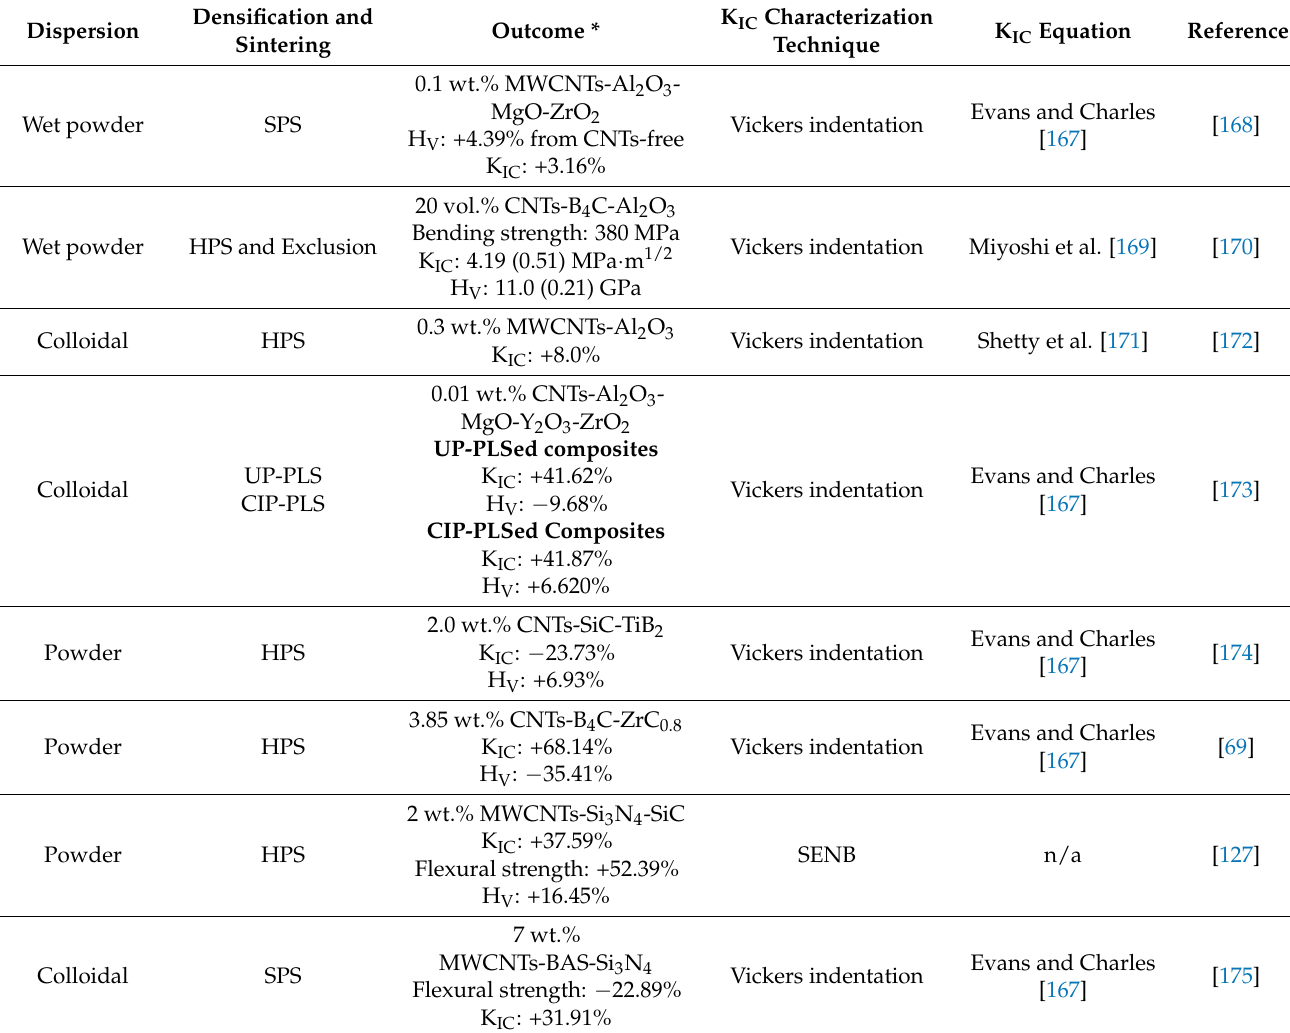
Table 11. Previous published work on the mechanical improvement of CNTs-CMCs. Compared to the monolithic CMCs, the enhancement % of optimized CNTS-CMCs are calculated unless stated